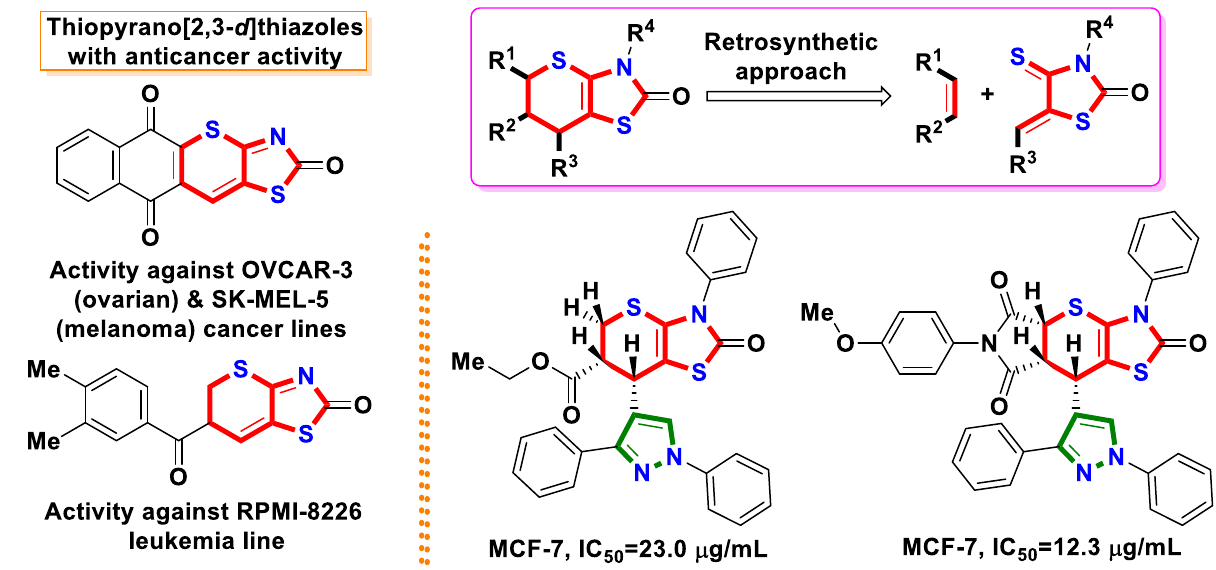
Figure 1. The scheme of the retrosynthetic approach to thiopyrano[2,3- d ]thiazoles and some examples of bioactive representatives from this class of heterocycles as background for the present research [1,8].